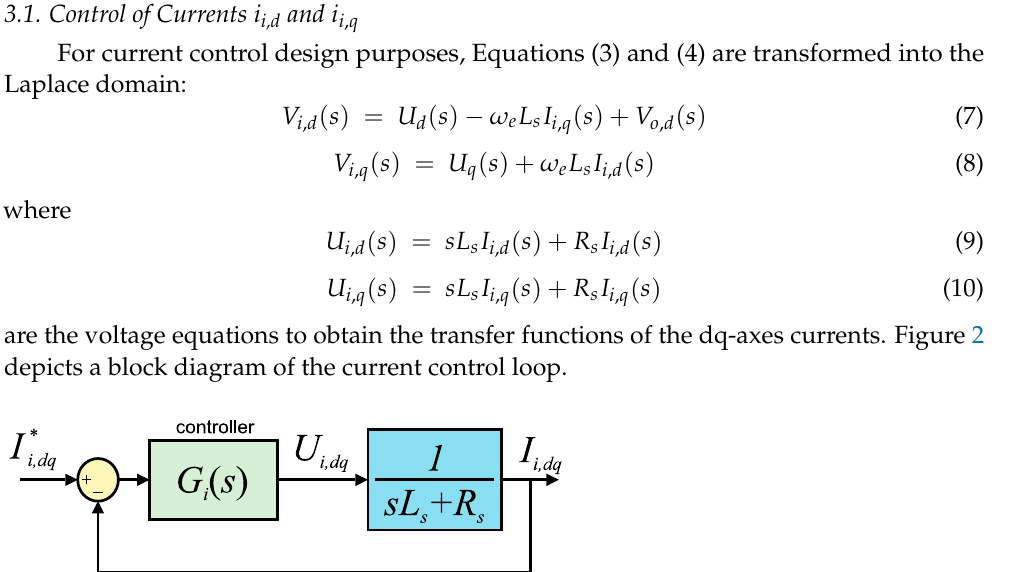
Figure 2. The current control loop.